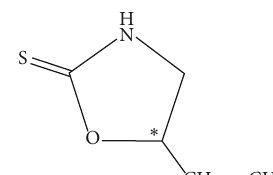
Figure 1: Chemical structures of (R,